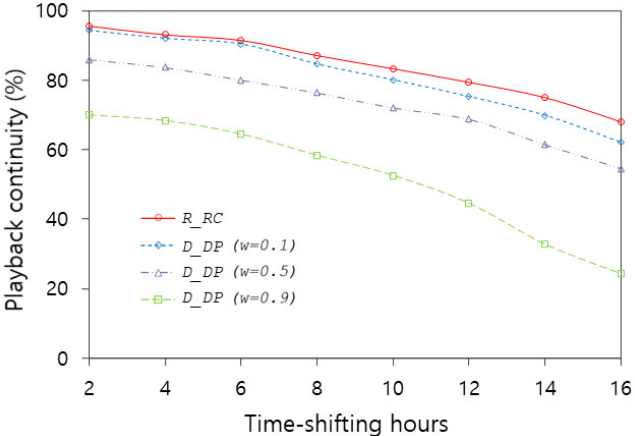
Figure 6. Comparison of playback requests between D _ DP and R _ RP in distribution 1 with a 450 s buffer.